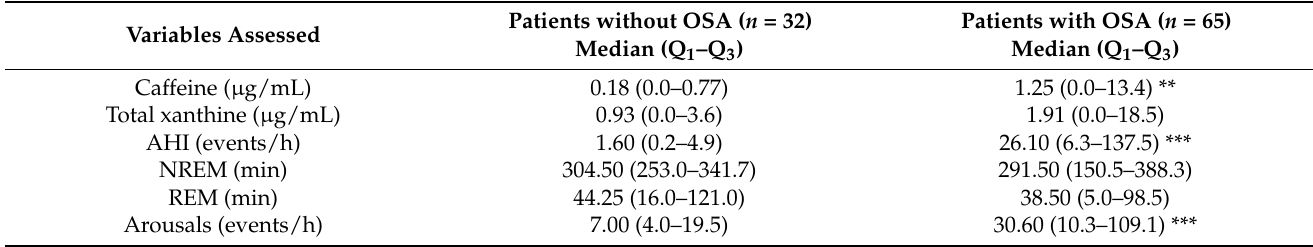
Table 2. Comparison of caffeine and total xanthine plasmatic concentrations, Apnea-hypopnea index (AHI), sleep architecture (REM and non-REM) and arousals events in patients with or without obstructive sleep apnea